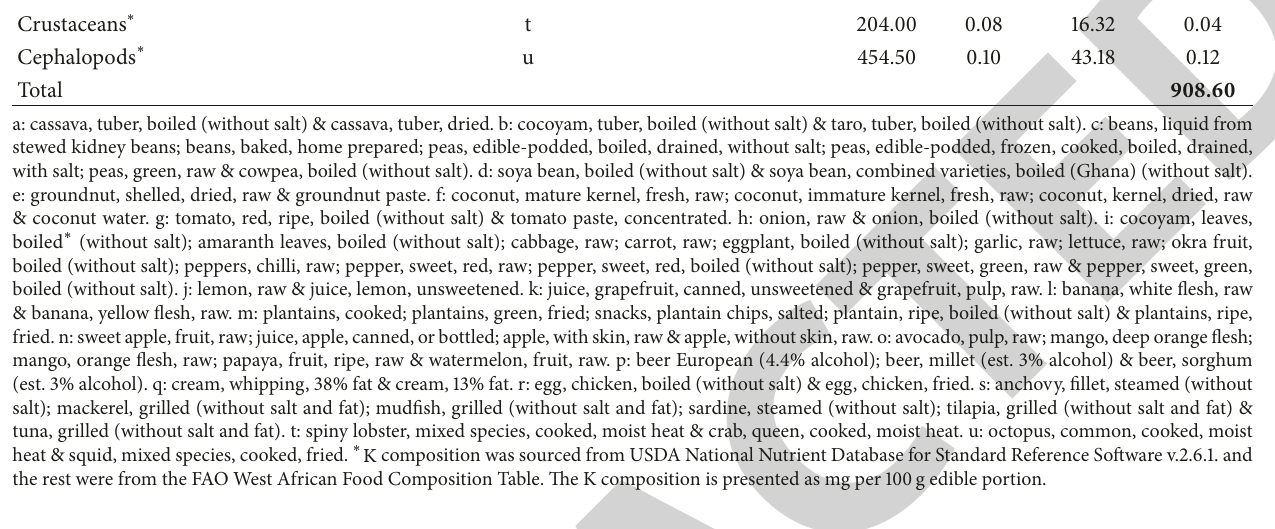
Table 2: Extent of adequacy of individual K intake for different sex and age categories in Ghana based on 2010-2011 average food supply. Female